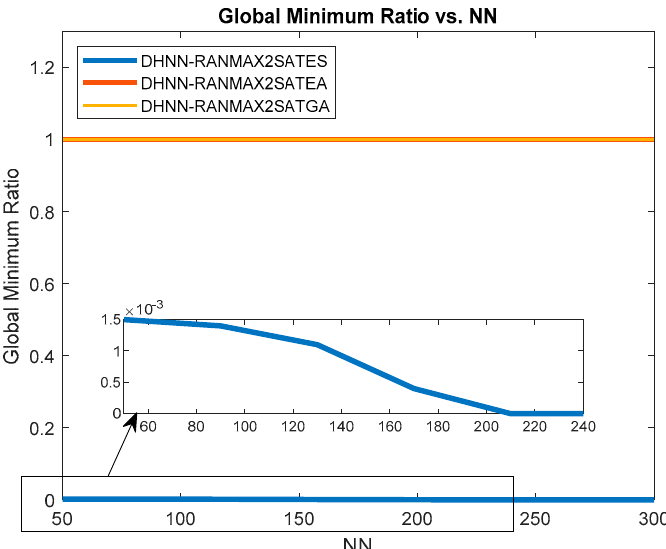
Figure 5. Global minimum ratio, Zm produced by